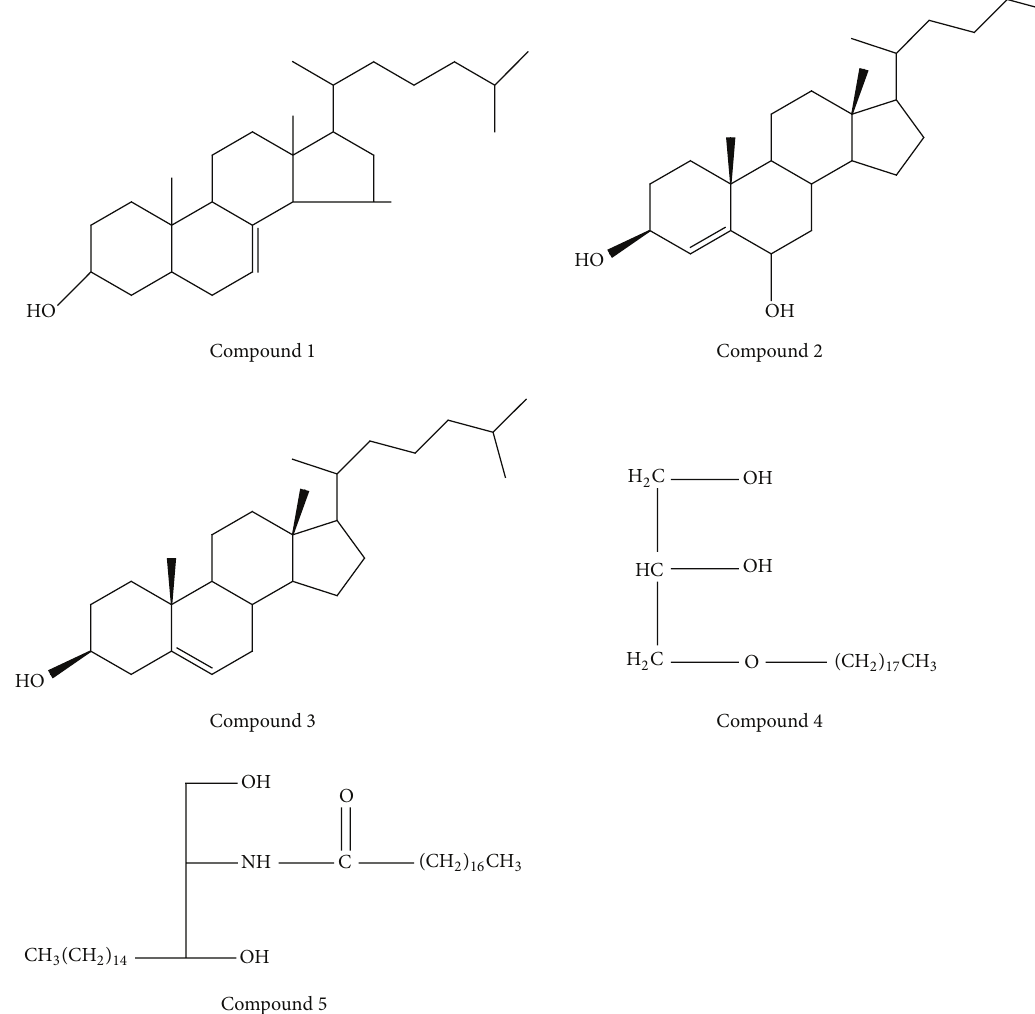
Figure 4: Structures of